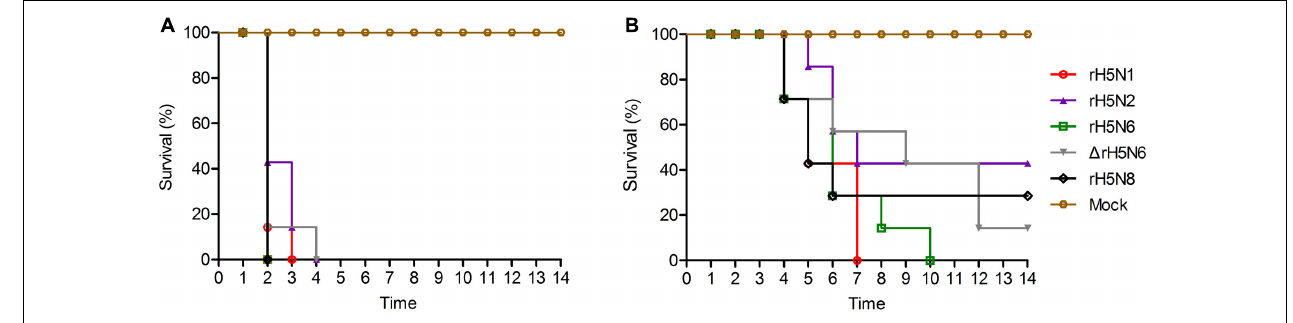
FIGURE 5 | Pathogenicity and transmission of H5Nx reassortant viruses in chickens. Groups of seven 5-week-old SPF chickens were inoculated intranasally with 10 5 EID 50 /200 µ l of the indicated viruses. Seven chickens were used as negative controls. (A) Survival rate of chickens infected with H5Nx reassortant viruses. (B) Survival rate of chickens co-housed with the animals infected indicated virus. All chickens were observed for clinical symptoms for 14 days.